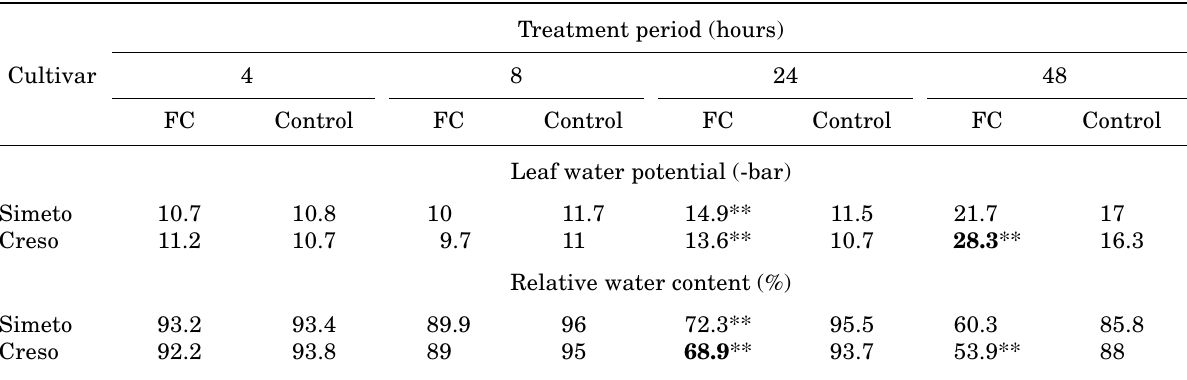
Table 2. Leaf water potential and relative water content of cut seedlings of two cultivars of durum wheat during